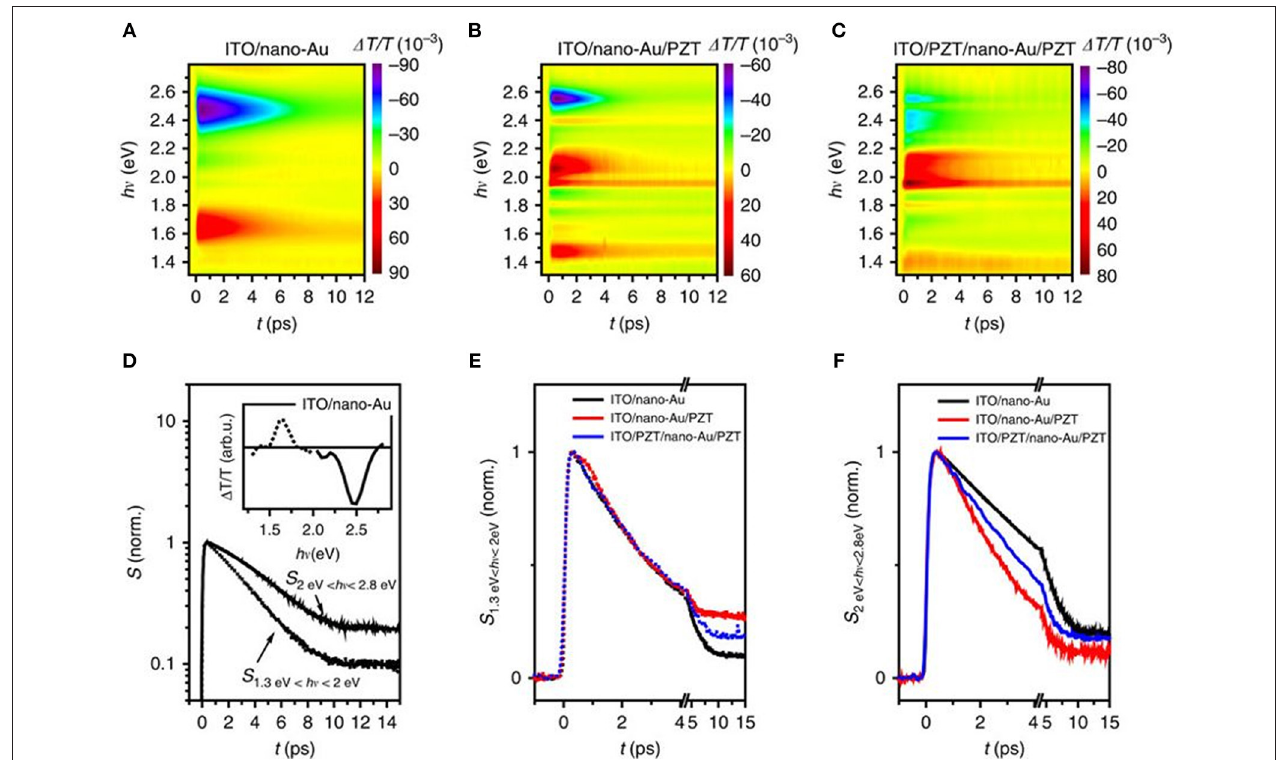
FIGURE 9 | Transient absorbance spectroscopy of the plasmonic-ferroelectric hybrids. Time evolution of 1 T/T for (A) ITO/nano-Au, (B) ITO/nano-Au/PZT, and (C) ITO/PZT/nano-Au/PZT, following photoexcitation with 70 fs ultraviolet pulses at 400nm. (D) The time evolution of the response for ITO/nano-Au in the low and high frequencies, respectively. Comparison of the (E) low-frequency and (F) high-frequency dynamics between the three nano-Au hybrids. Figure adapted from Wang et al. (2016). Copyright 2016 Nature Publishing